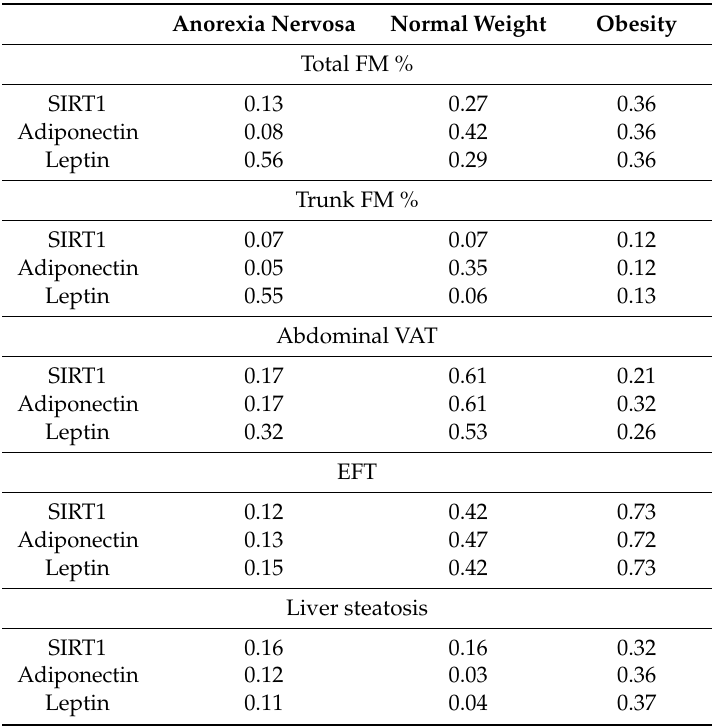
Table 3. Measures of performance of SIRT1, adiponectin and leptin to predict FM distribution by linear regression squared coe ffi cient (R 2